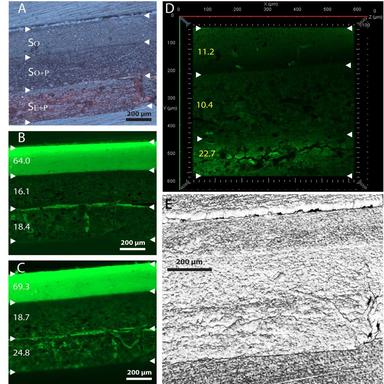
Cross section images of the red coloured micro (model) sample, containing the pigment madder lake, photographed prior to antibody hybridization using the reflectedlight brightfield observation (texp 2.9 ms, frame A) and the widefield fluorescence observation (texp 500 ms, frame B) modes. After antibody hybridization, the sample was again captured in the widefield fluorescence observation mode under the same illumination conditions (frame C) and was laser scanned using confocal fluorescence microscopy (maste